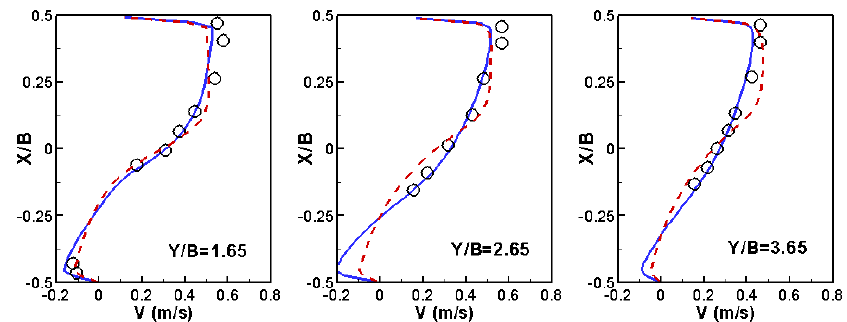
Figure 4. Comparison of V velocity profiles at selected y locations in the side channel (Solid Blue Line: SRH-3D; Red Dashed Line: SRH-2D; Symbol: Experiment).